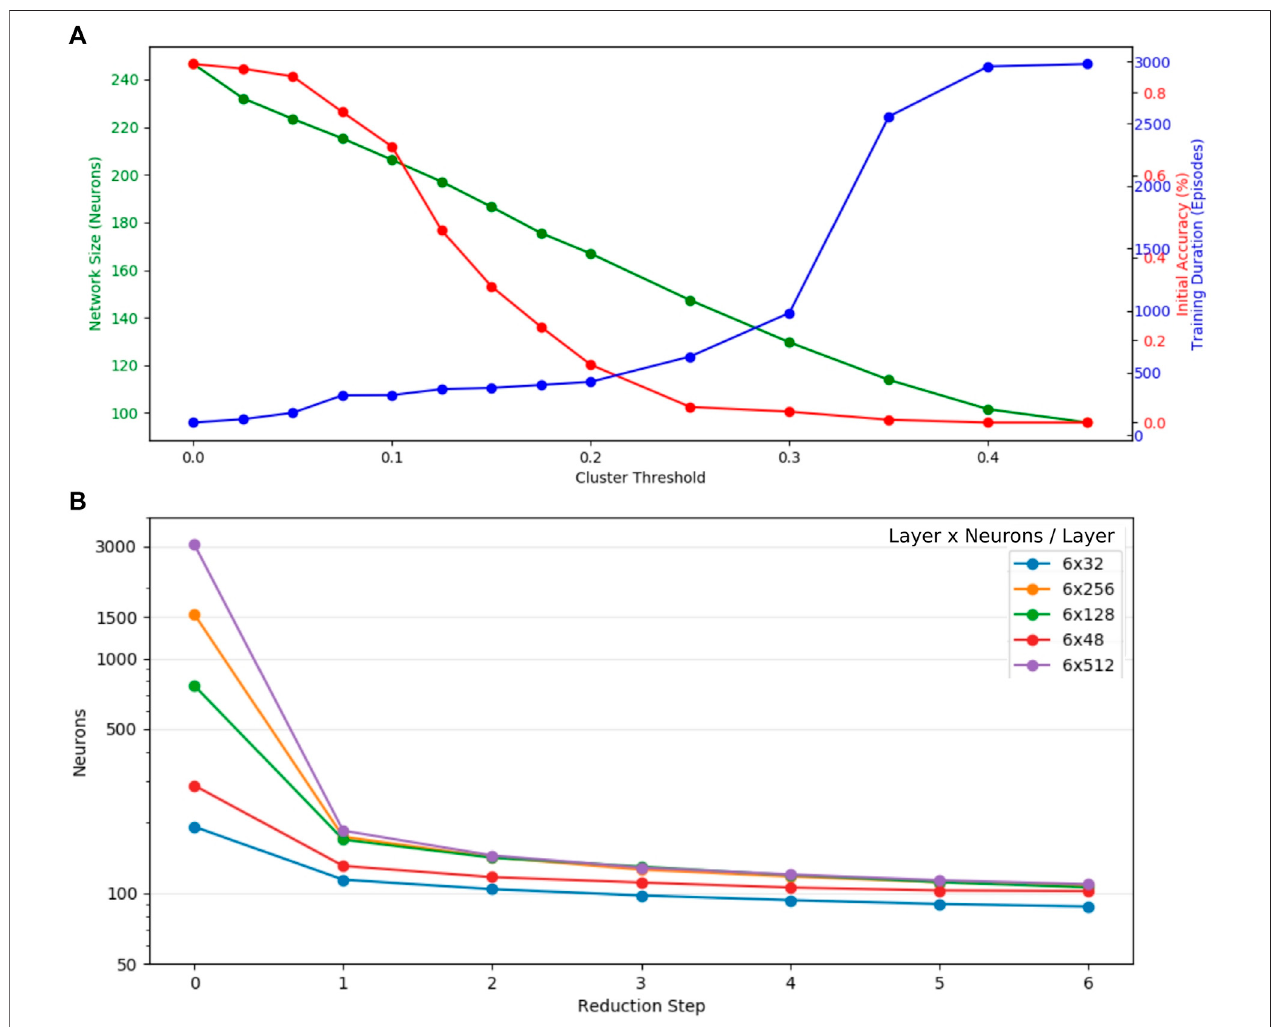
FIGURE 4 | Evaluation of heuristic cluster-based network pruning on the example of a three-joint manipulator. (A) Even though the initial network accuracy decreasesrapidly,thetrainingduration(numberofepisodesexecuteduntilthevalidationsetispassed)onlyincreasessigni fi cantlywithclusterthresholdslargerthan0.3. As a trade-off between minimal network size after pruning and ef fi cient training τ = 0.2 has been picked as the optimal cluster threshold and was applied for all further experiments. (B) The fi rst reduction step shows the strongest reduction for all networks. They have been initialized with a different neuron count per layer. Layers with more than 128 neurons are reduced to a very similar neuron count in the fi rst pruning step.